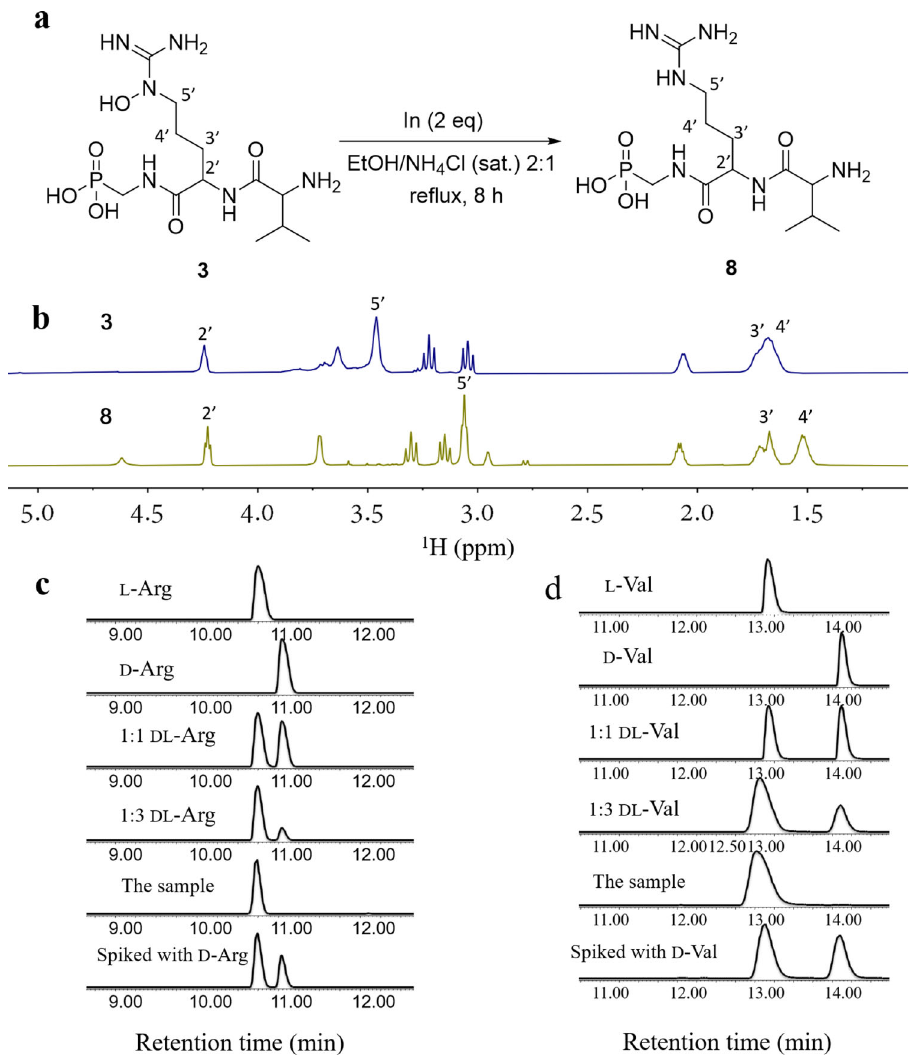
Fig. 2 Determination of absolute con fi guration of argolaphos A (3). a Indium-mediated reduction of N 5 -hydroxyarginine in 3 led to compound 8 . b Comparison of 1 H NMR spectrum of 3 and 8 . c Marfey analysis for determination of the absolute con fi guration of arginine in 8 . LC-HRMS chromatograms were monitored at m/z = 427.160 for the N -(5- fl uoro-2,4-dinitrophenyl)- D -alaninamide (FDAA) derivatives of standard L -arginine, D -arginine, DL -arginine, the sample, and the sample spiked with D -arginine. d Marfey analysis for determination of the absolute con fi guration of valine in 8 . LC-HRMS chromatograms were monitored at m/z = 370.136 for the N -(5- fl uoro-2, 4-dinitrophenyl)- D -alaninamide (FDAA) derivatives of standard L -valine, D -valine, DL -valine, the sample, and the sample spiked with D